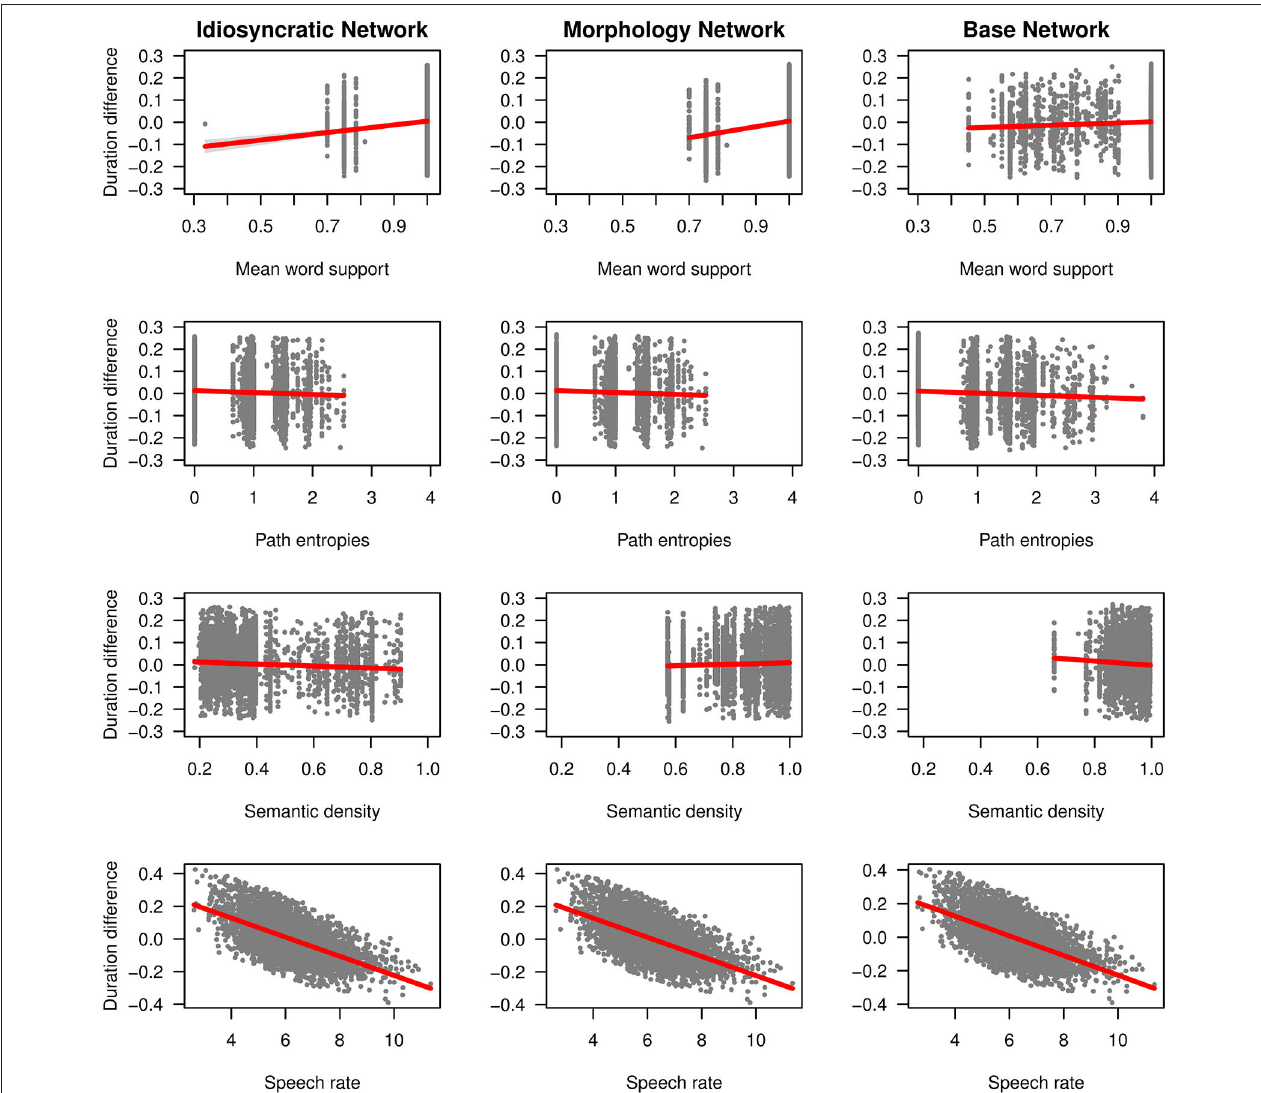
FIGURE 3 | Effects on duration difference in the standard linear regression models for the Idiosyncratic Network variables (left column), the Morphology Network variables (middle column) and the Base Network variables (right